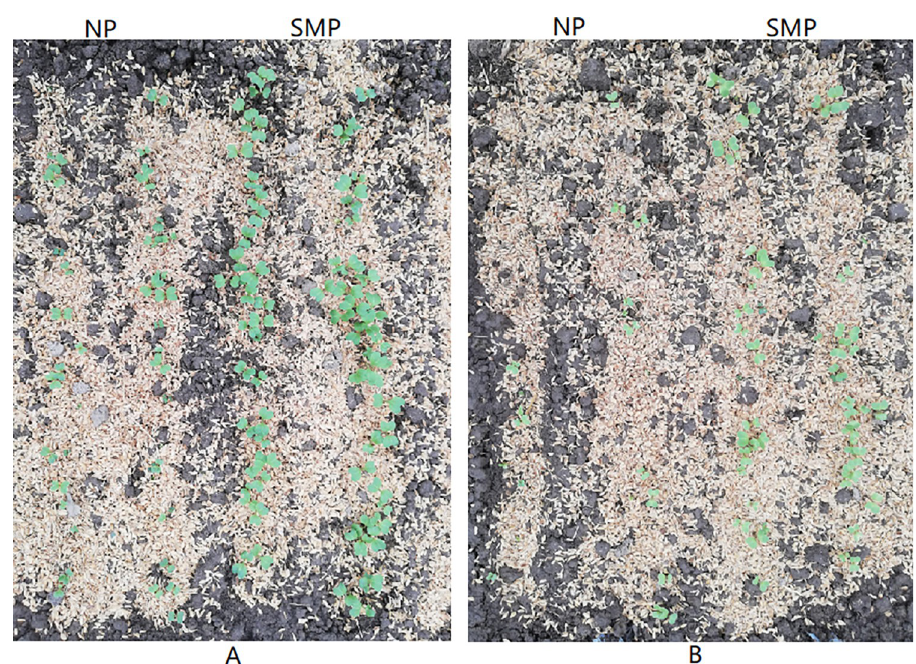
Fig 4. Images of emergences of nonprimed (NP) or solid matrix primed (SMP) cauliflower and broccoli seeds. (A) Emergence of broccoli seeds. (B) Emergence of cauliflower seeds. Images were taken 16 days after sowing. The emergence test using nonprimed control seeds and SM-primed seeds of cauliflower and broccoli was performed in a glasshouse. For each treatment, 2 biological replicates with 50 seeds each were sown in a glasshouse.